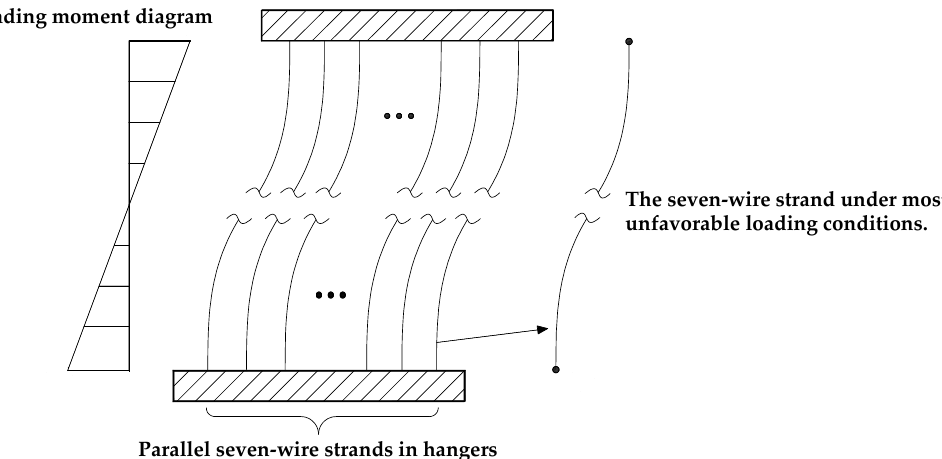
Figure 13. Mechanical model of the parallel seven-wire strands in the hangers considering lateral bending deformation.